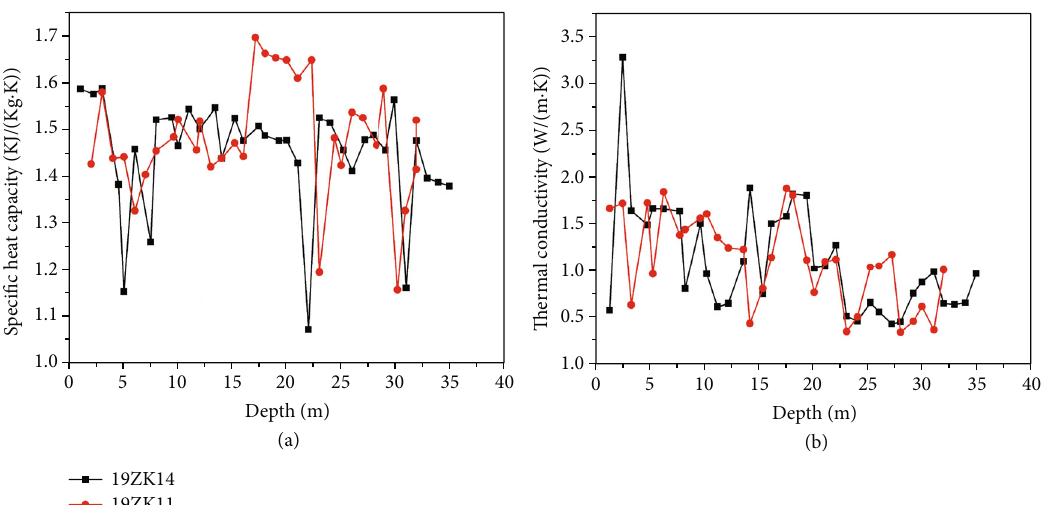
Figure 4: Variation curve of speci fi c heat capacity (a) and thermal conductivity (b) of the rock-soil body around K11 and K14 with depth.